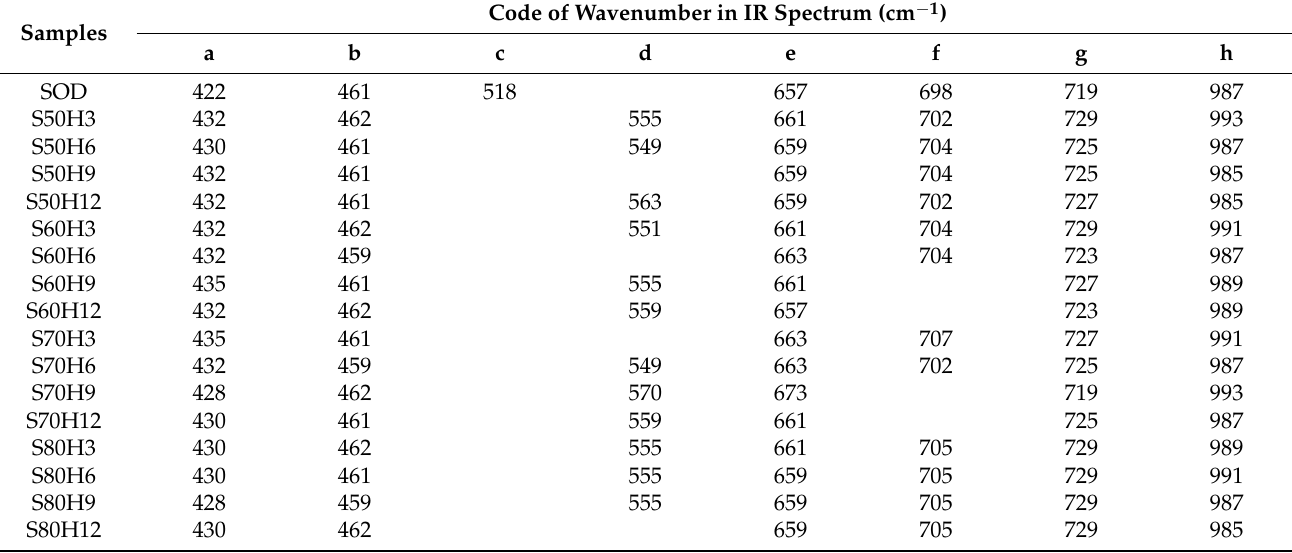
Table 3. Wave number IR spectrum of synthesized solid.